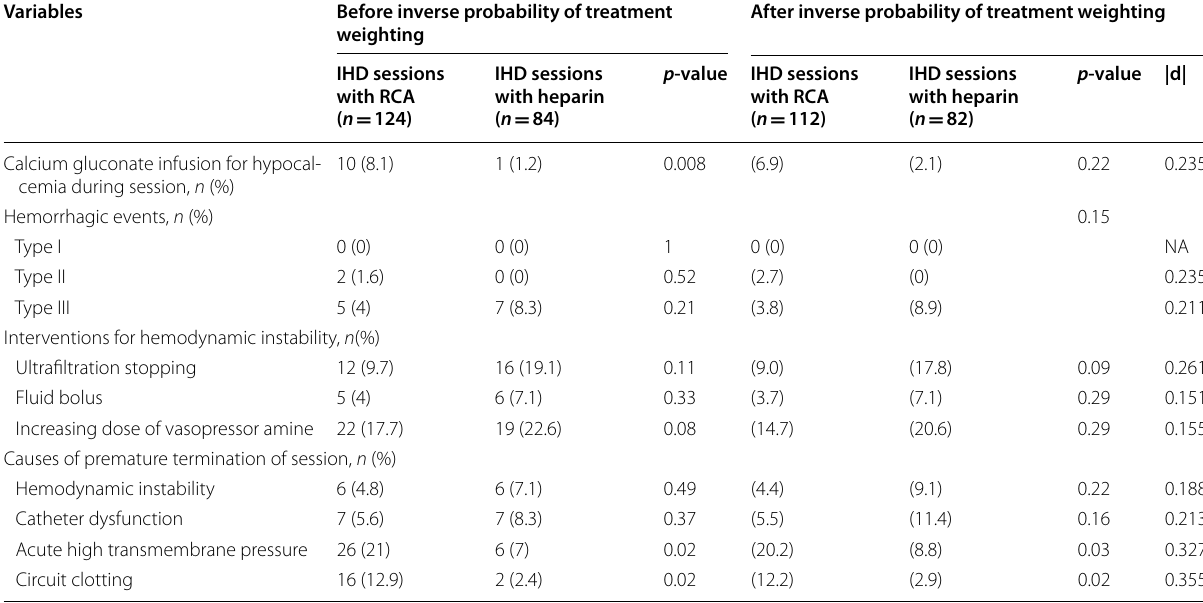
Table 3 Comparison in safety between RCA and heparin anticoagulation for